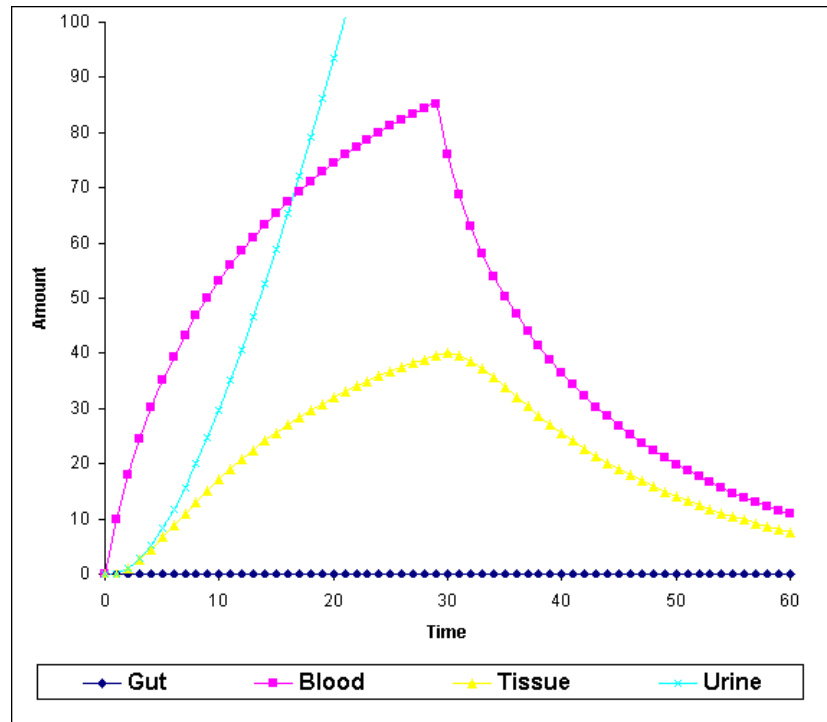
FIGURE 6 . Typical simulation of intravenous pharmacokinetics. The simulation shows a continuous intravenous infusion of 10 units of dose per minute for a period of 30 min.